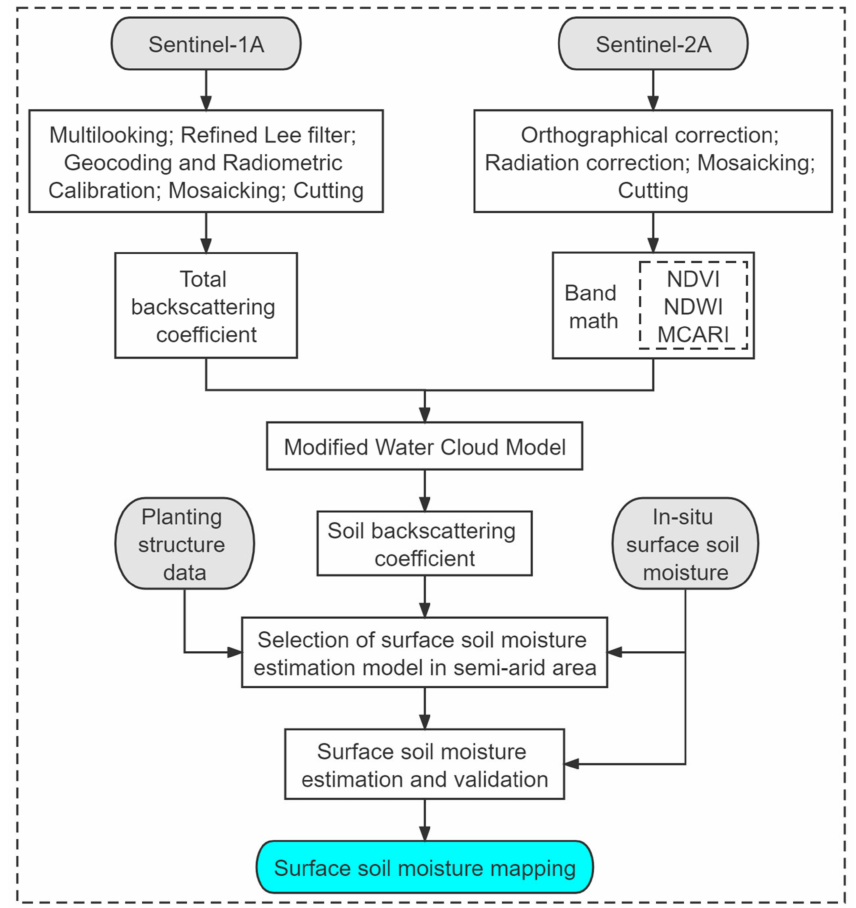
Figure 4. Workflow of this